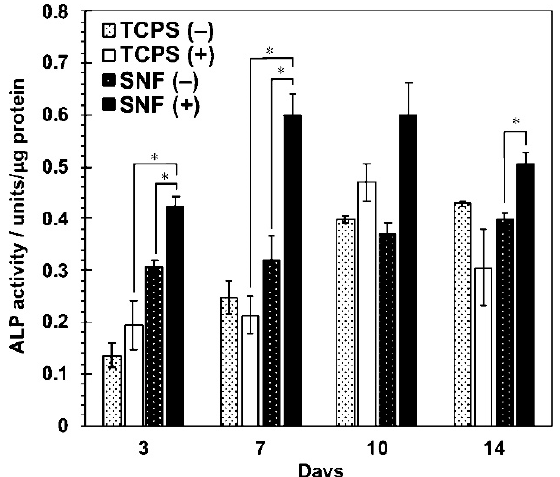
Figure 5. Alkaline phosphatase (ALP) activity of MSCs cultured on SNFs and TCPS plates under the normal medium ( − ) and the osteogenic di ff erentiation medium (+). Data are shown as the mean ± S. E. ( n = 4). * indicates significance ( p < 0.05, Student’s t -test). ACS Omega, Iijima et al. [36].